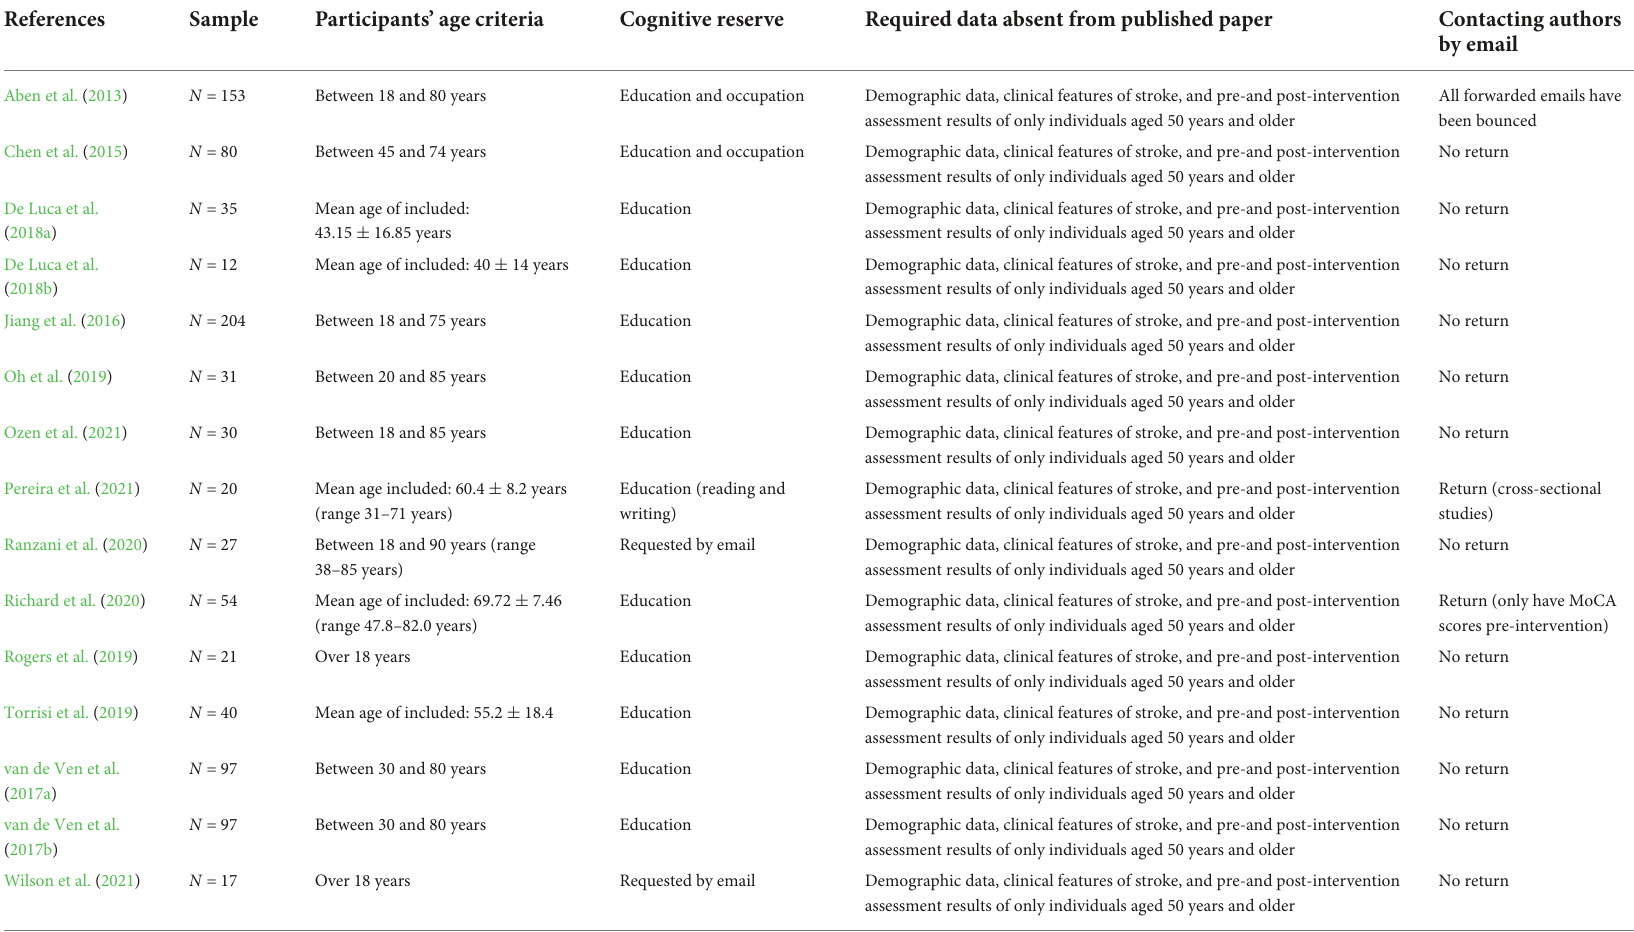
TABLE 1 Characteristics of studies that were contacted and then